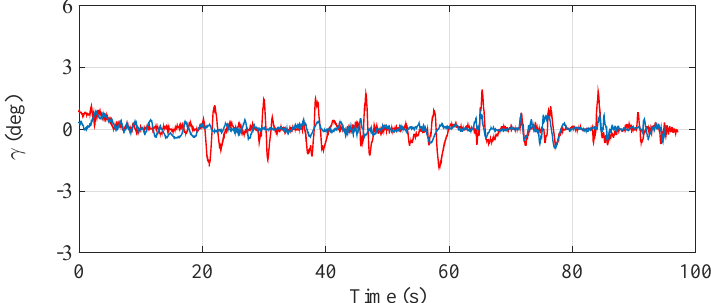
Figure 27. Inclination of the SCMS frame ( γ ) when the optimization is carried out with a α equal to zero ( — ) and when the optimization is not considered ( —